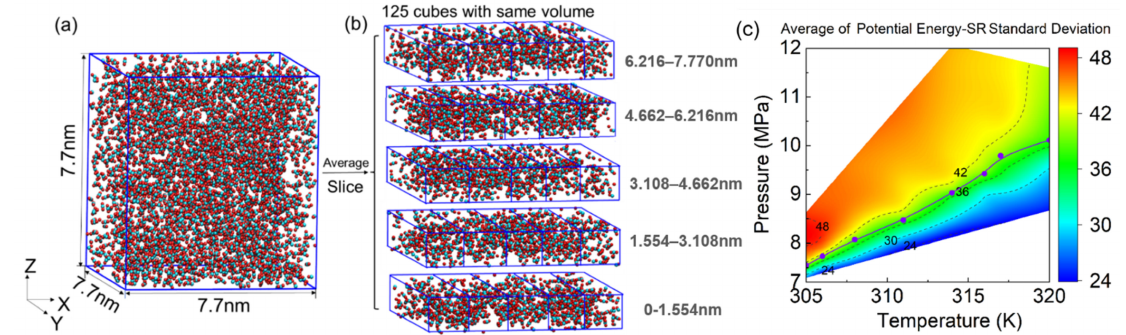
Figure 4. Model design for analysis of local changes in CO 2 parameters. ( a ) Treated simulation systems, ( b ) approaches used for fluctuation properties, ( c ) iso-hypes lines of potential energy- SR standard deviation. (For in-depth interpretation of these data, readers are referred to the Liu et al. paper [54]).